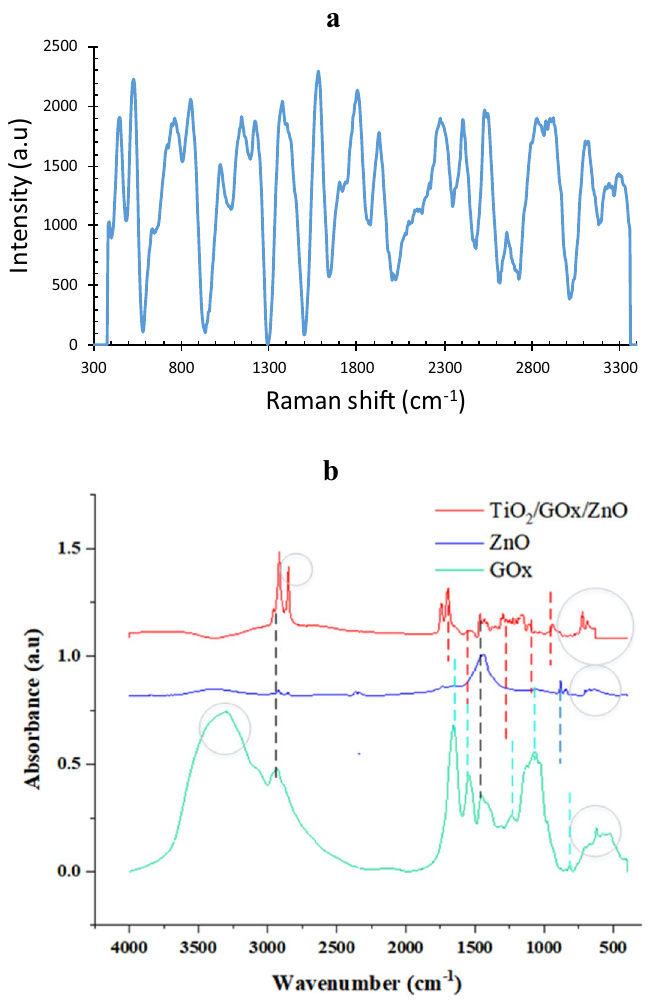
Figure 9. ( a ) Raman spectra of GOx/ZnO immobilized on TiO 2, ( b ) FTIR analysis of the bio-photo-catalyst